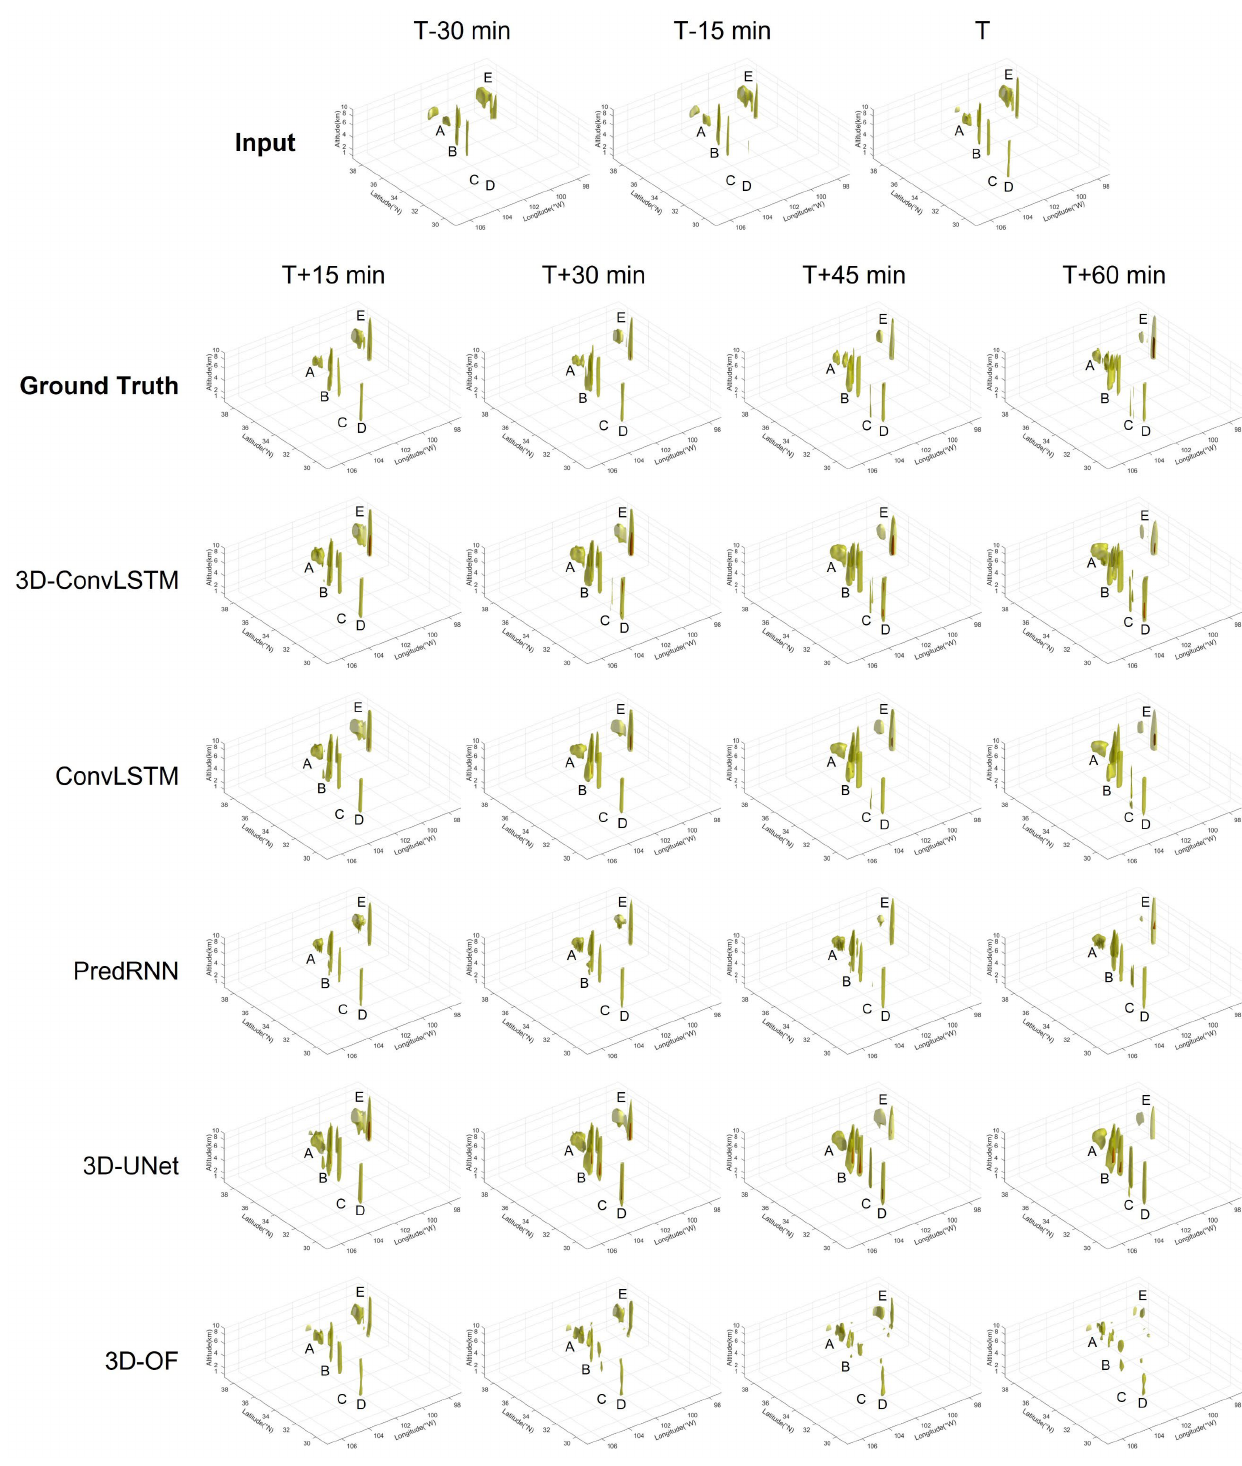
Figure 8. Severe storm event observed at longitudes 106.99–97.01 W and latitudes 29.01–38.99 N in U.S. on 7 May 2019, and its 3D storm nowcasts beginning at time T = 7 May 2019, 21:20 UTC. Storms with reflectivity values greater than 35 and 45 dBZ are shown in yellow and red, respectively. Letters A – E represent different regions where storm evolution occurred.